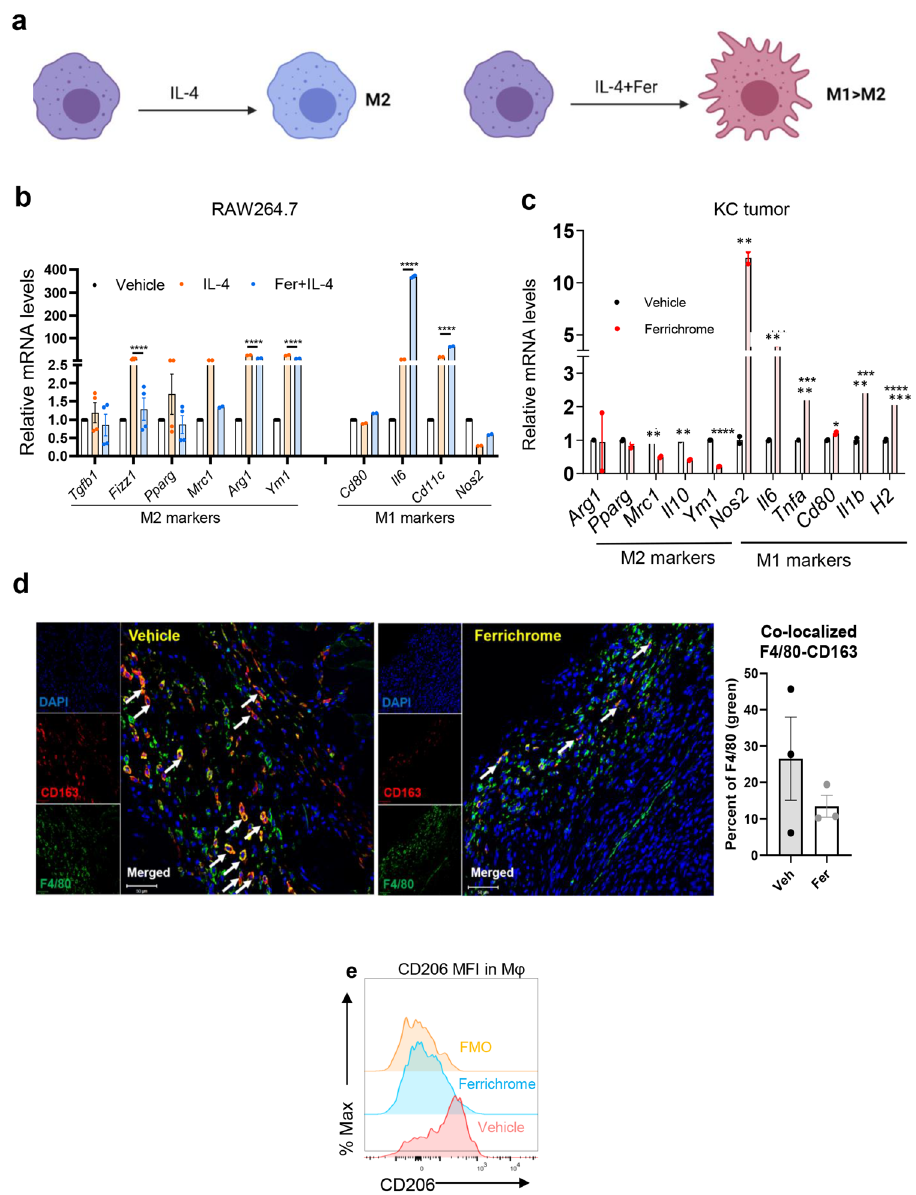
Fig. 2 Ferrichrome abrogates M2 polarization of macrophages and promotes M1-like phenotype in vitro and in vivo. a Representative scheme of in vitro polarization of RAW264.7 macrophages. M2 polarization of RAW264.7 cells were induced by culture with IL-4 (20 ng/mL) in the presence of ferrichrome or vehicle control (1× PBS) for 24 h. Control consisted of vehicle treated RAW264.7 cells. RNA was collected for qPCR analysis. b Differential gene expression of M1 and M2 biomarkers between IL-4-treated and ferrichrome (8 μ M) + IL-4-treated RAW264.7 cells after 24 h of culture as evaluated by qPCR analysis. Graph is representative of two or more independent experiments with N = 2 – 4. c Differential gene expression of M1 and M2 markers in UN- KC-6141 tumors treated with vehicle or ferrichrome (pooled from n = 3 biological replicates). d Representative images and quanti fi cation of dual staining of macrophage markers F4/80 (green) and CD163 (red) in tumors treated with ferrichrome or vehicle as evaluated via immuno fl uorescence and imaged using confocal microscopy. Quanti fi cation was evaluated using ImageJ ( n = 4). Nucleus was stained with DAPI (blue). Bar on micrographs indicates 50 µ m. e Representative histogram of M2 marker CD206 Mean Fluorescence Intensity (MFI) in gated macrophages (CD45 + CD11b + Ly6C − Ly6G − F4/80 + ) of ferrichrome (blue) or vehicle-treated (red) tumor single cell suspensions as evaluated by fl ow cytometry analysis ( n = 4 experiments). Fluorescence Minus One (FMO) (orange) was used as a negative control. Mean± SEM shown ** p < 0.05, *** p < 0.01, and **** p < 0.001, as determined by Student ’ s t test or two-way